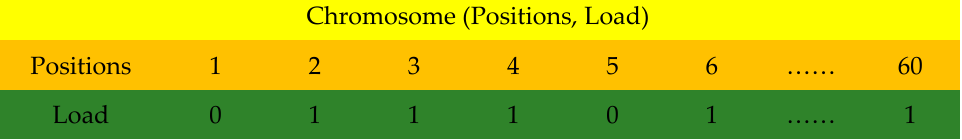
Figure 4. Schematic diagram of position code.